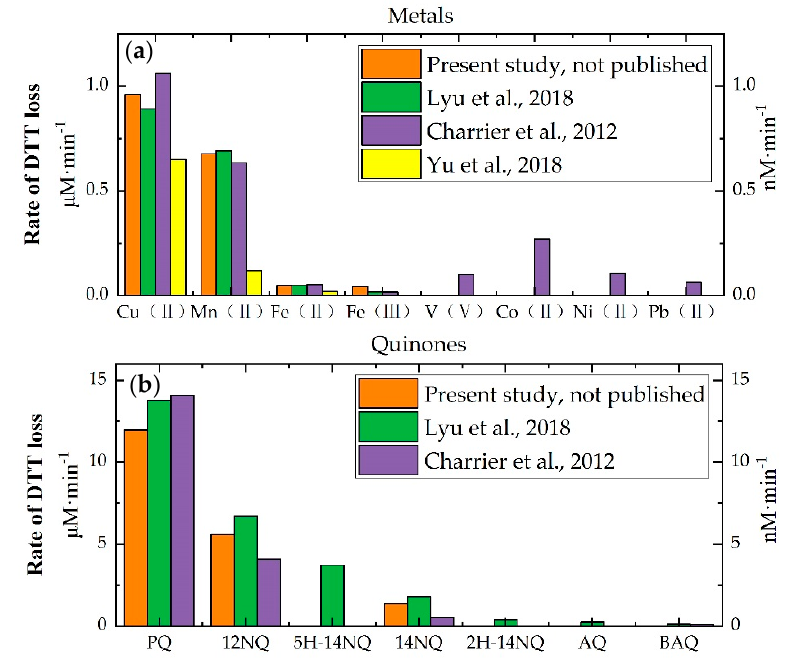
Figure 9. Intrinsic OP of individual ( a ) metals and ( b ) quinones [24,67,73]. The concentration of each species was 1 µ M. The data in this paper are in nM · min − 1 while in other literatures they are in µ M · min − 1 .